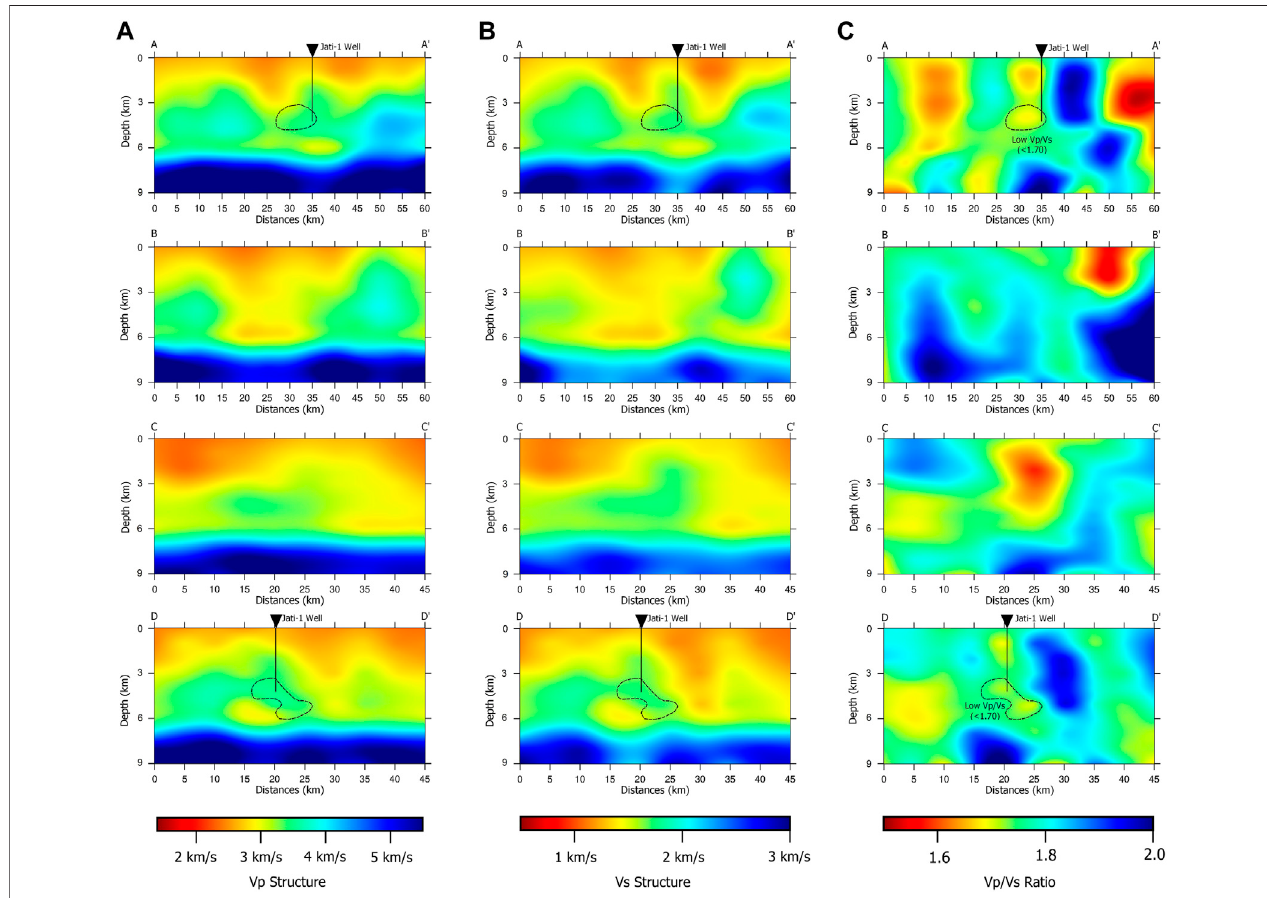
FIGURE 10 | Vertical sections of Vp (A) , Vs (B), and Vp/Vs ratio (C) . Line A – A ′ and D – D ′ intersected Jati-1 well (shown by black-colored inverted triangle) with a target depth of 4, 400 m. Based on vertical sections of Vs, the Jati-1 well is directly above the anticline structure as shown by Vp and Vs vertical sections. In the target depth of Jati-1 well, Vp/Vs ratio shows a low anomaly region ( < 1.7).